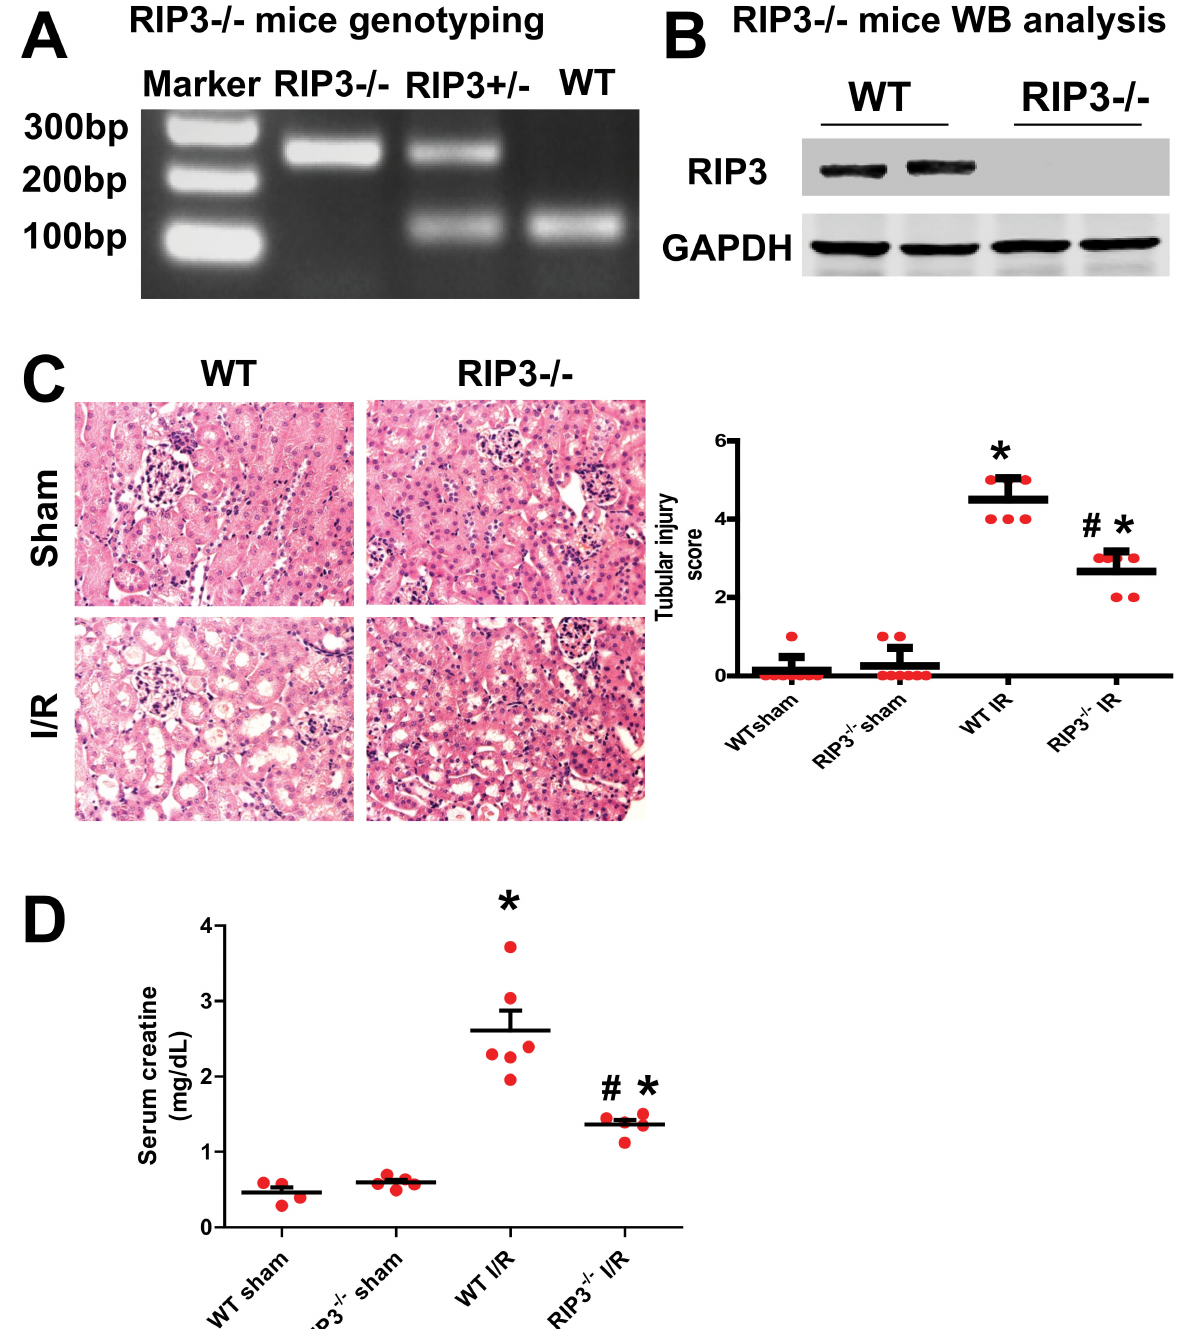
Figure 3. RIP3 − / − mice exhibit a decrease in kidney injury after renal I/R. ( A ) Genotype used to confirm the RIP3 +/ − and RIP3 − / − mice versus the littermate WT mouse. Note that the RIP3 +/ − heterozygote mouse displayed both alleles (knockout and WT bands). ( B ) Immunoblot confirming the knockdown of RIP3 in RIP3 − / − versus littermate WT mice. ( C ) Left: H&E staining images showing an increase in kidney injury in WT mice after renal I/R compared to the sham-operated animals. However, in RIP3 − / − mice, the tubular injury was reduced when compared to littermate WT mice after renal I/R. Right: Graph showing an increase in kidney injury score in WT mice after renal I/R compared to the sham-operated animals. However, in RIP3 − / − mice, the tubular injury was reduced when compared to littermate WT mice after renal I/R. Note that there was no